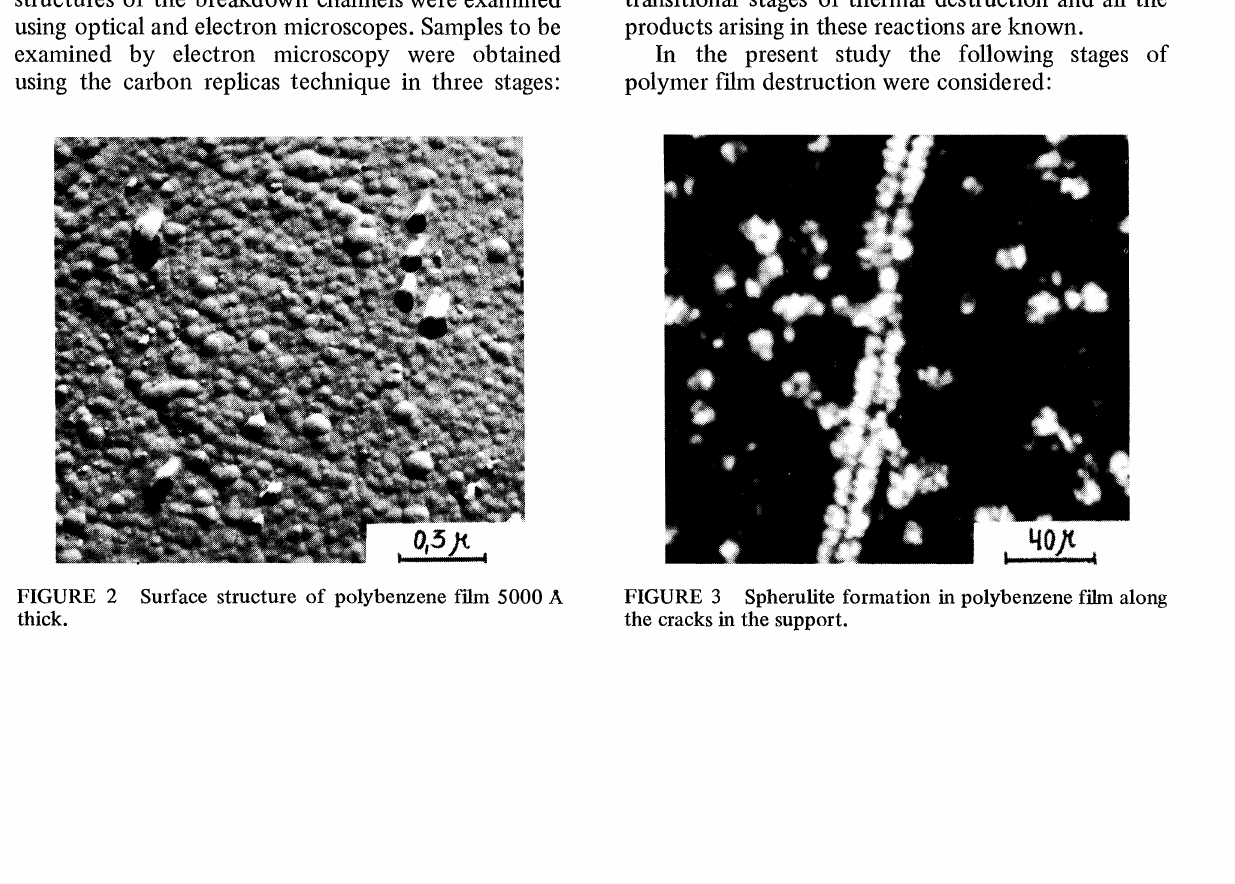
FIGURE 3 Spherulite formation in polybenzene film along the cracks in the